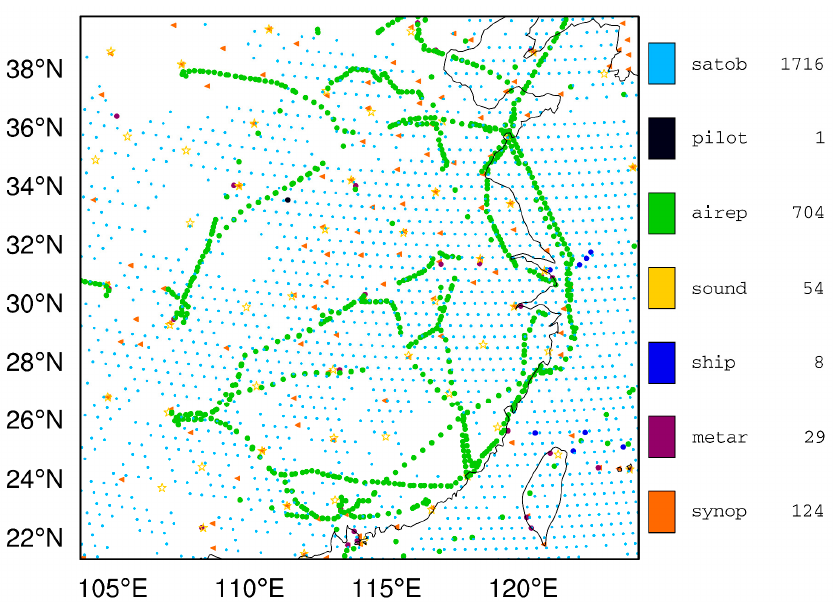
Figure 4. Conventional observations valid at 0000 UTC 23 June 2017.